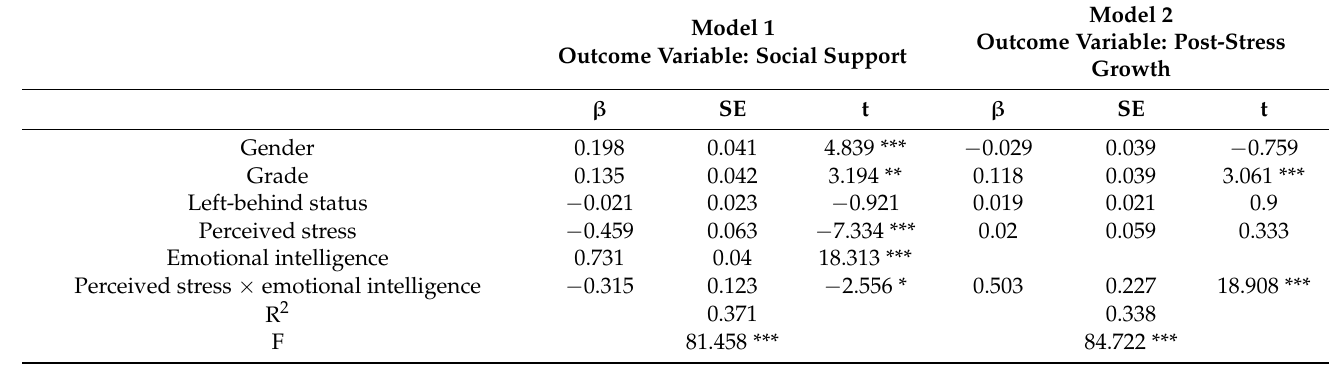
Table 4. Moderated mediation model analysis